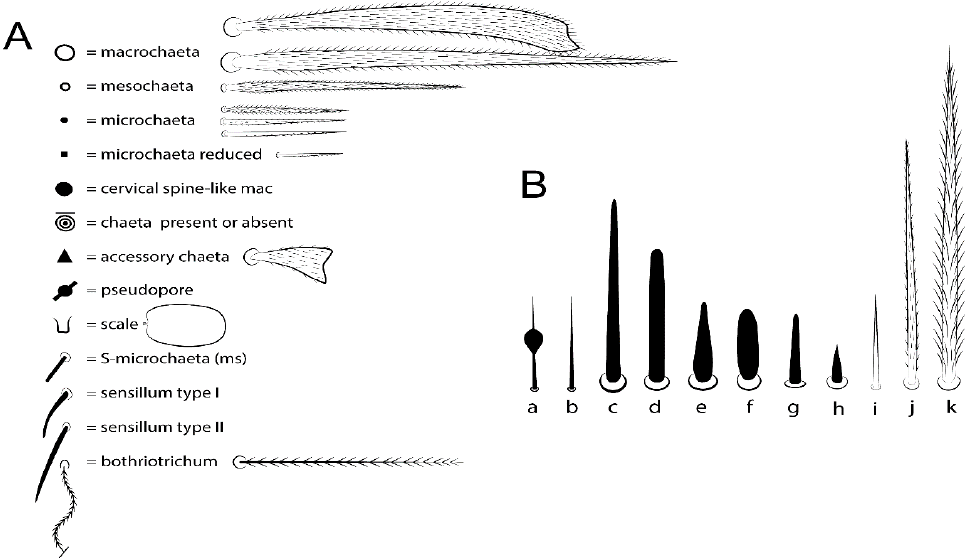
Figure 1. Symbols and chaetae drawings used for chaetotaxy descriptions of Pseudosinella species. ( A ) dorsal chaetotaxy; ( B ) Ant I–IV